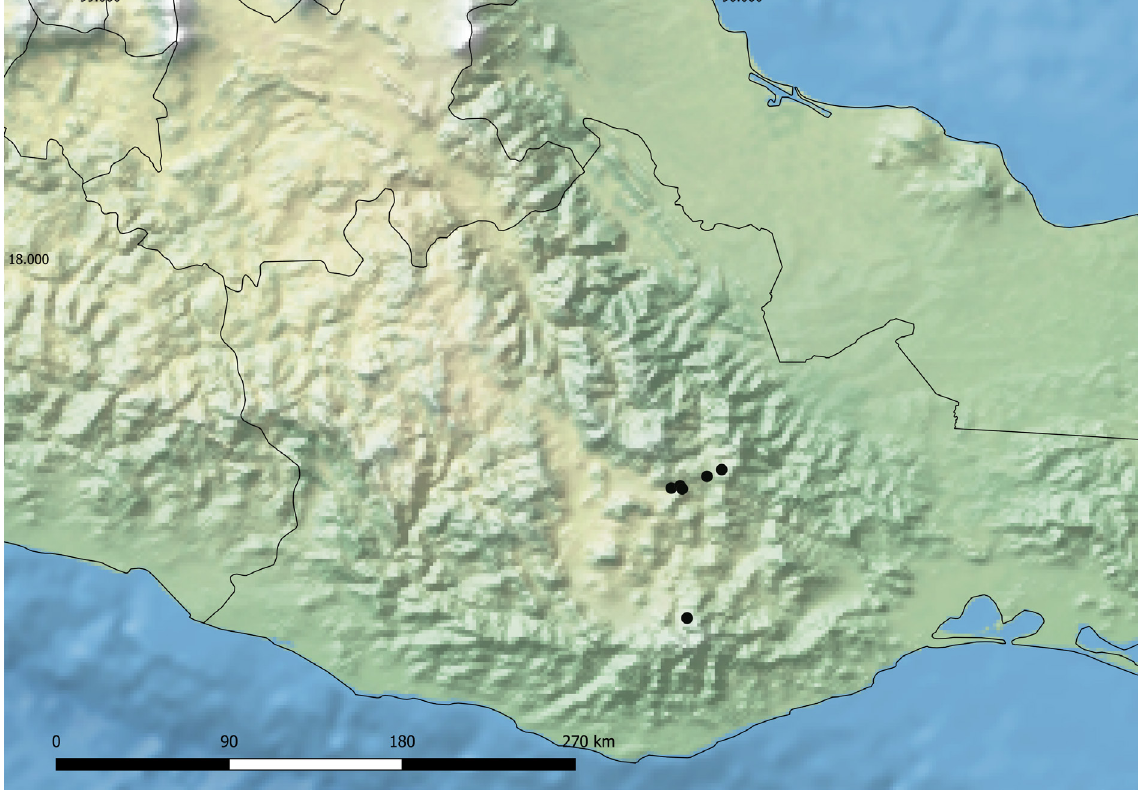
Fig. 11. Locality records of Salvadora gymnorhachis Hernández-Jiménez, Flores-Villela & Campbell,